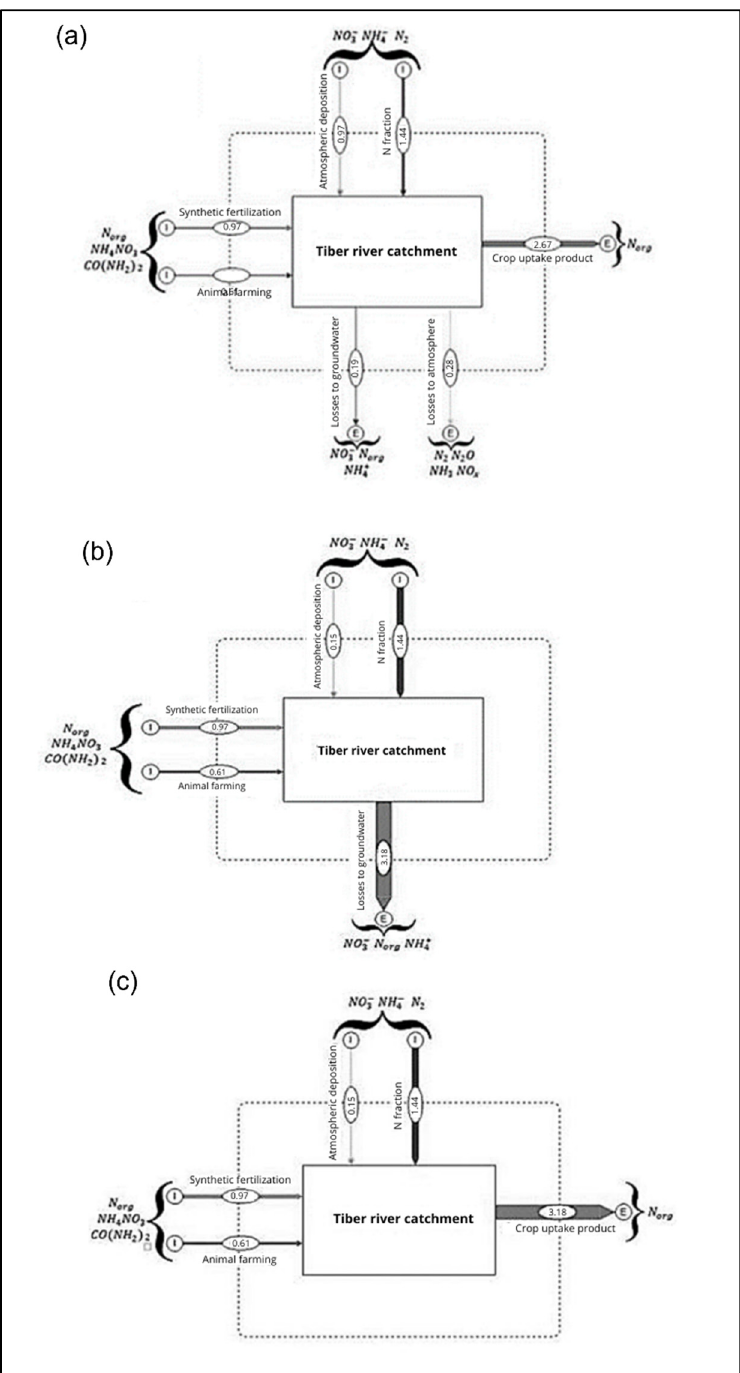
Figure 2. Tiber river catchment system’s N budget. The four input fluxes were synthetic fertilization, farming animals, atmospheric deposition, and N fixation. Three fluxes were the outputs: ammonia volatilization, denitrification in soil, and crop uptake product) ( a ); worst entropy H max scenario ( b ); minimal entropy scenario H opt ( c ). All of the data were normalized to 1 Kg N/ha year anthropogenic input (animal farming, synthetic fertilization, and N fixation from seeds) (modified from [72]).